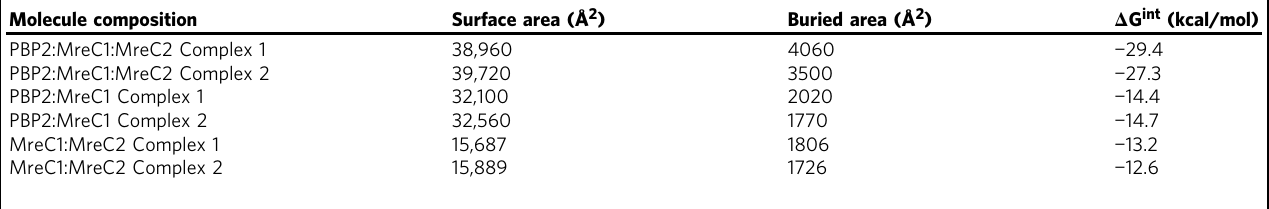
Table 1 Pisa assembly list Molecule composition